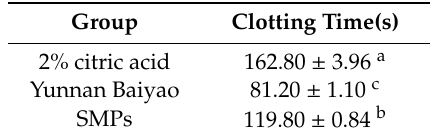
Table 3. Determination of plasma recalcification coagulation